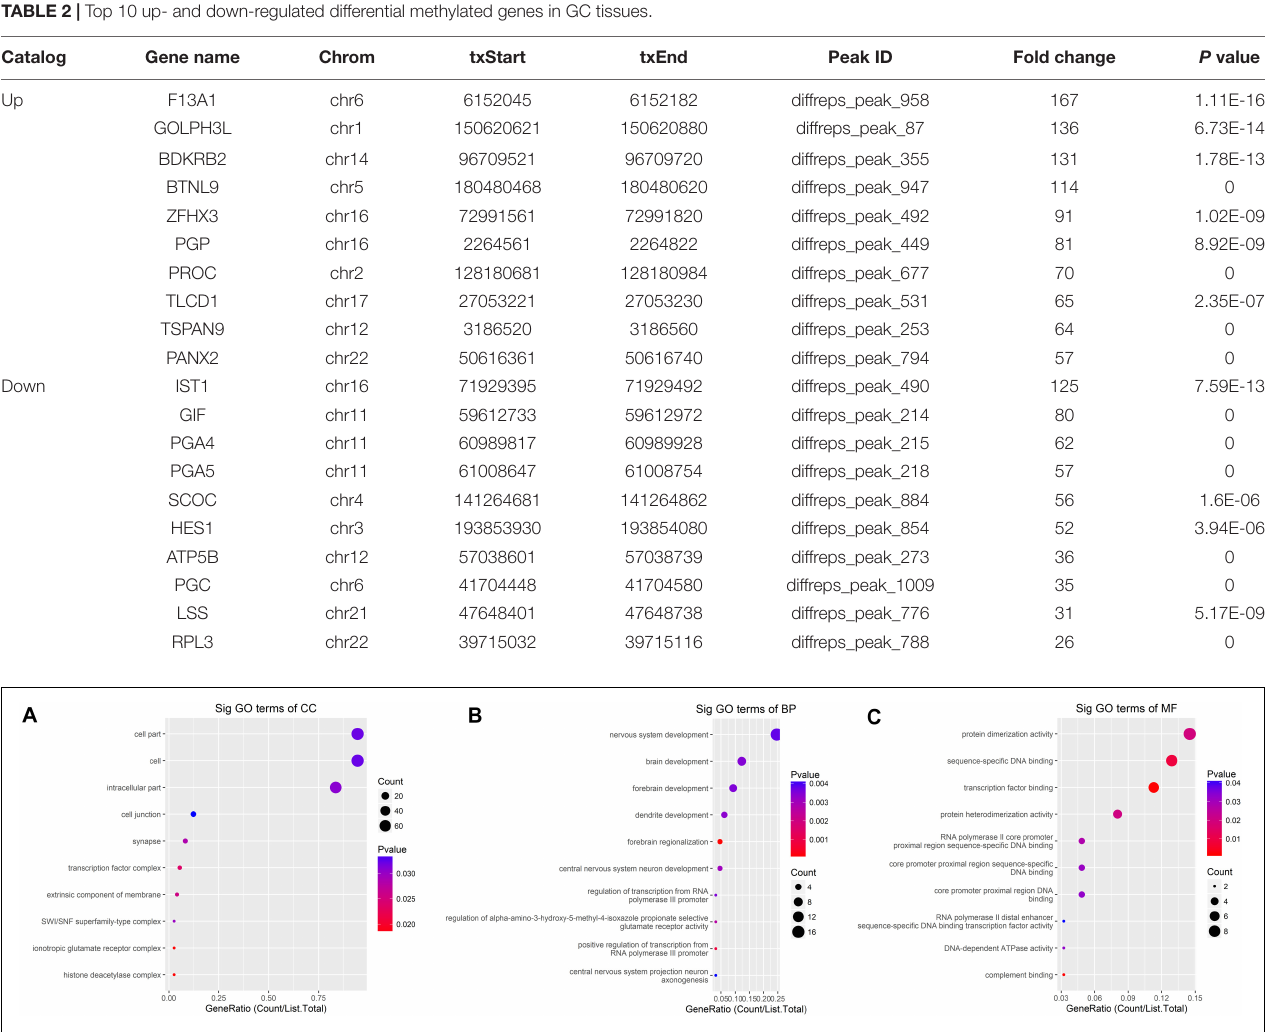
FIGURE 4 | GO terms for mRNAs with increased m6A levels. (A) Cellular component, (B) biological process, (C) molecular function. The genes are mainly enriched in the histone deacetylase complex, ionotropic glutamate receptor complex, and transcription factor complex and are involved in a variety of molecular functions including transcription factor binding, complement binding, sequence-specific DNA binding, and biological progresses referred to forebrain regionalization and positive regulation of transcription from RNA polymerase III